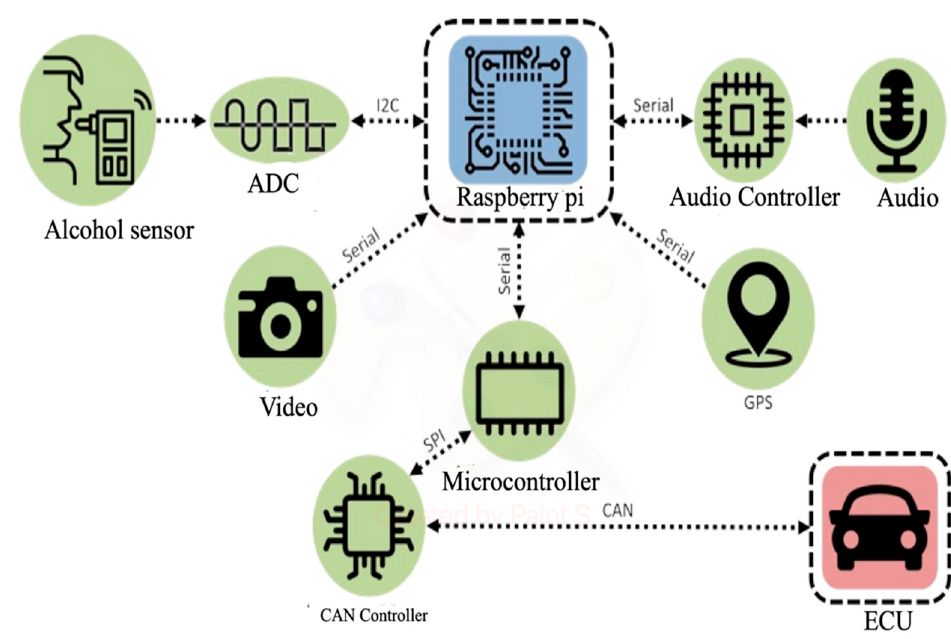
Figure 2. The sensors and communication protocols.